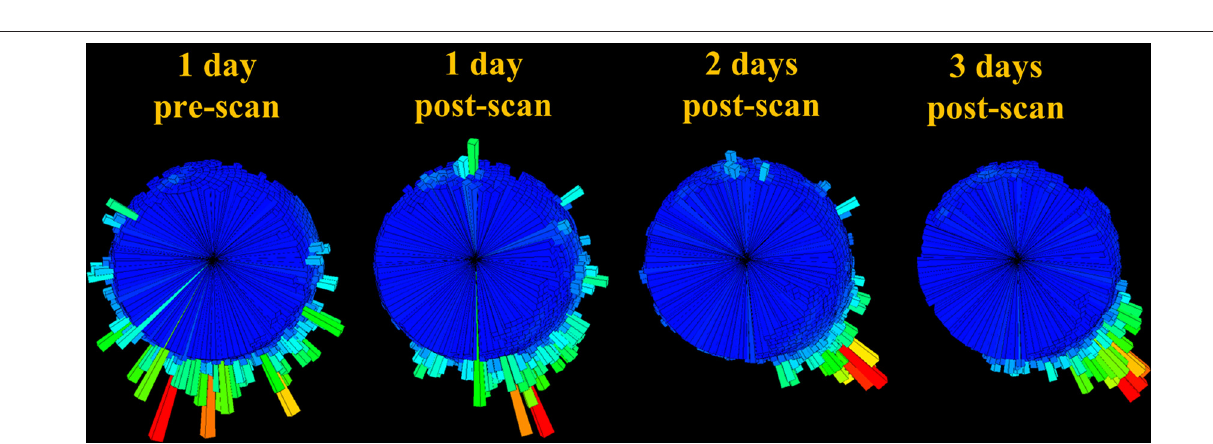
FIGURE 7 | Spherical magnetometer histogram plot (m-plot see Williams et al., 2017) showing relative time allocation (bar height and color; the mode is shown in red) to direction in rehabilitating turtles during a 24h period. Individuals are identified by number (see Table 1 ) and suffered from various diseases including gas emboli (GE). Note the generally higher directionality observed in healthy individuals and the clear lack of directionally in animals T331 and T332.